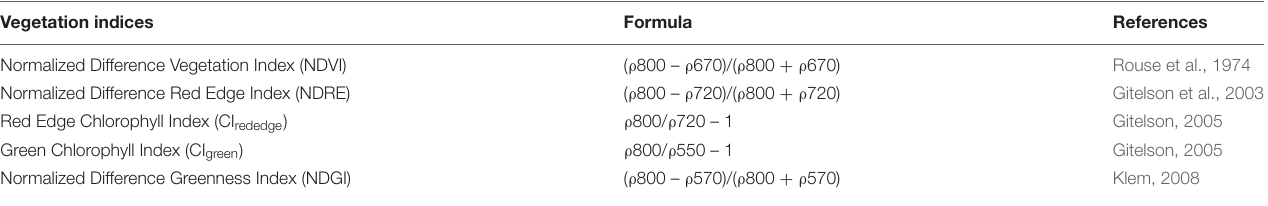
TABLE 2 | The details of the vegetation indices used in this study. Vegetation